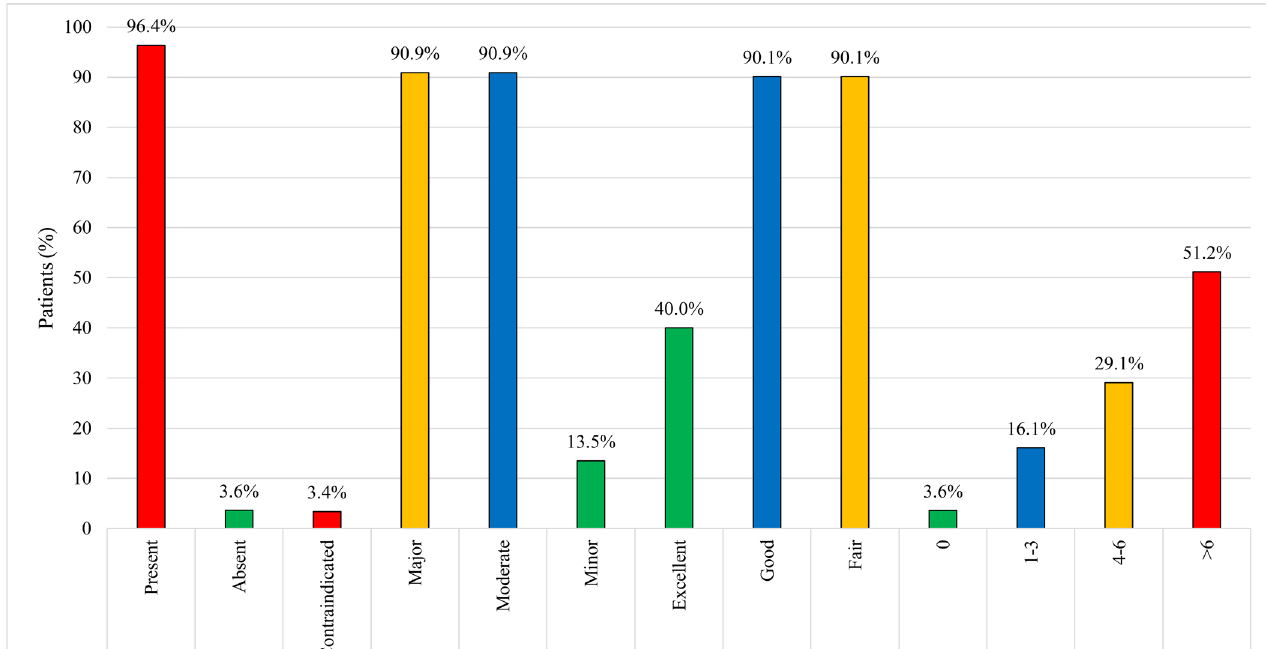
FIGURE 1 - Frequencies of pDDIs = Potential drug-drug interactions. Number of pDDIs per patient: Median = 7 (Inter quartile range =